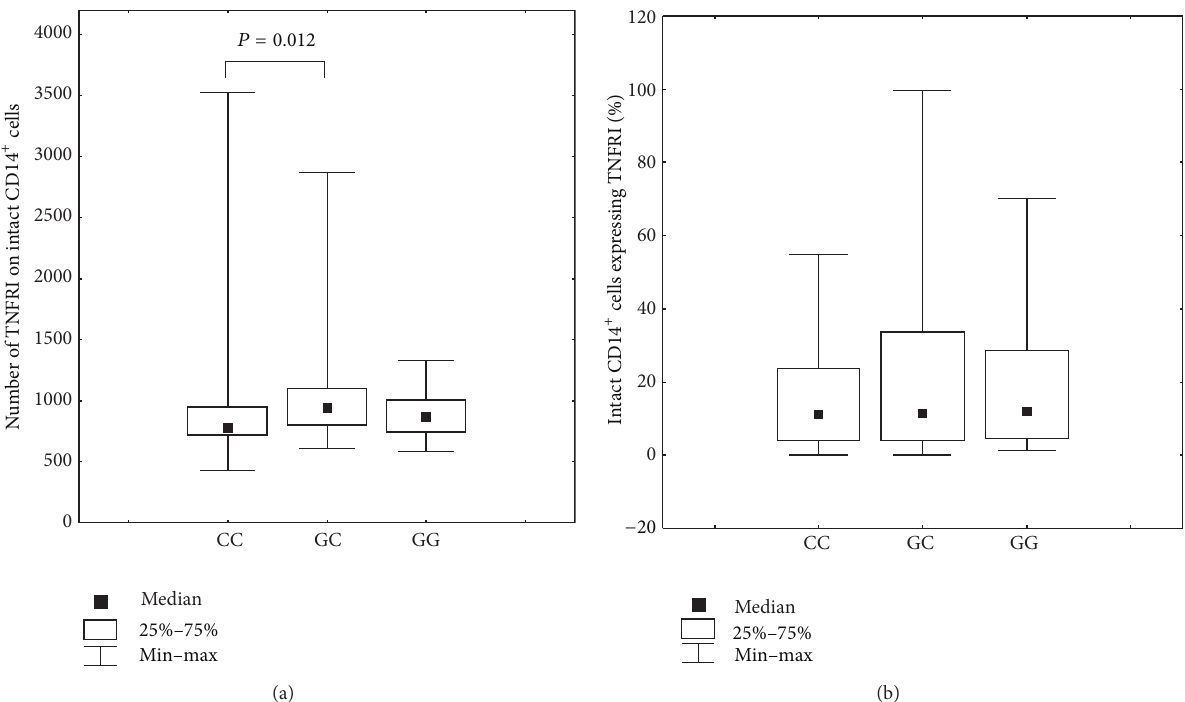
Figure 2: (a) Number of membrane-bound TNFRI present on CD14 + monocytes in individuals presenting with different SNP TNFRI − 1207G/C (rs4149569) genotypes. Kruskal-Wallis 𝐻 test, 𝑃 = 0.025 , Mann-Whitney 𝑈 test: CC versus GC, 𝑃 = 0.012 . (b) Percentage of CD14 + cells expressing TNFRI in individuals presenting with different SNP TNFRI − 1207G/C (rs4149569) genotypes.